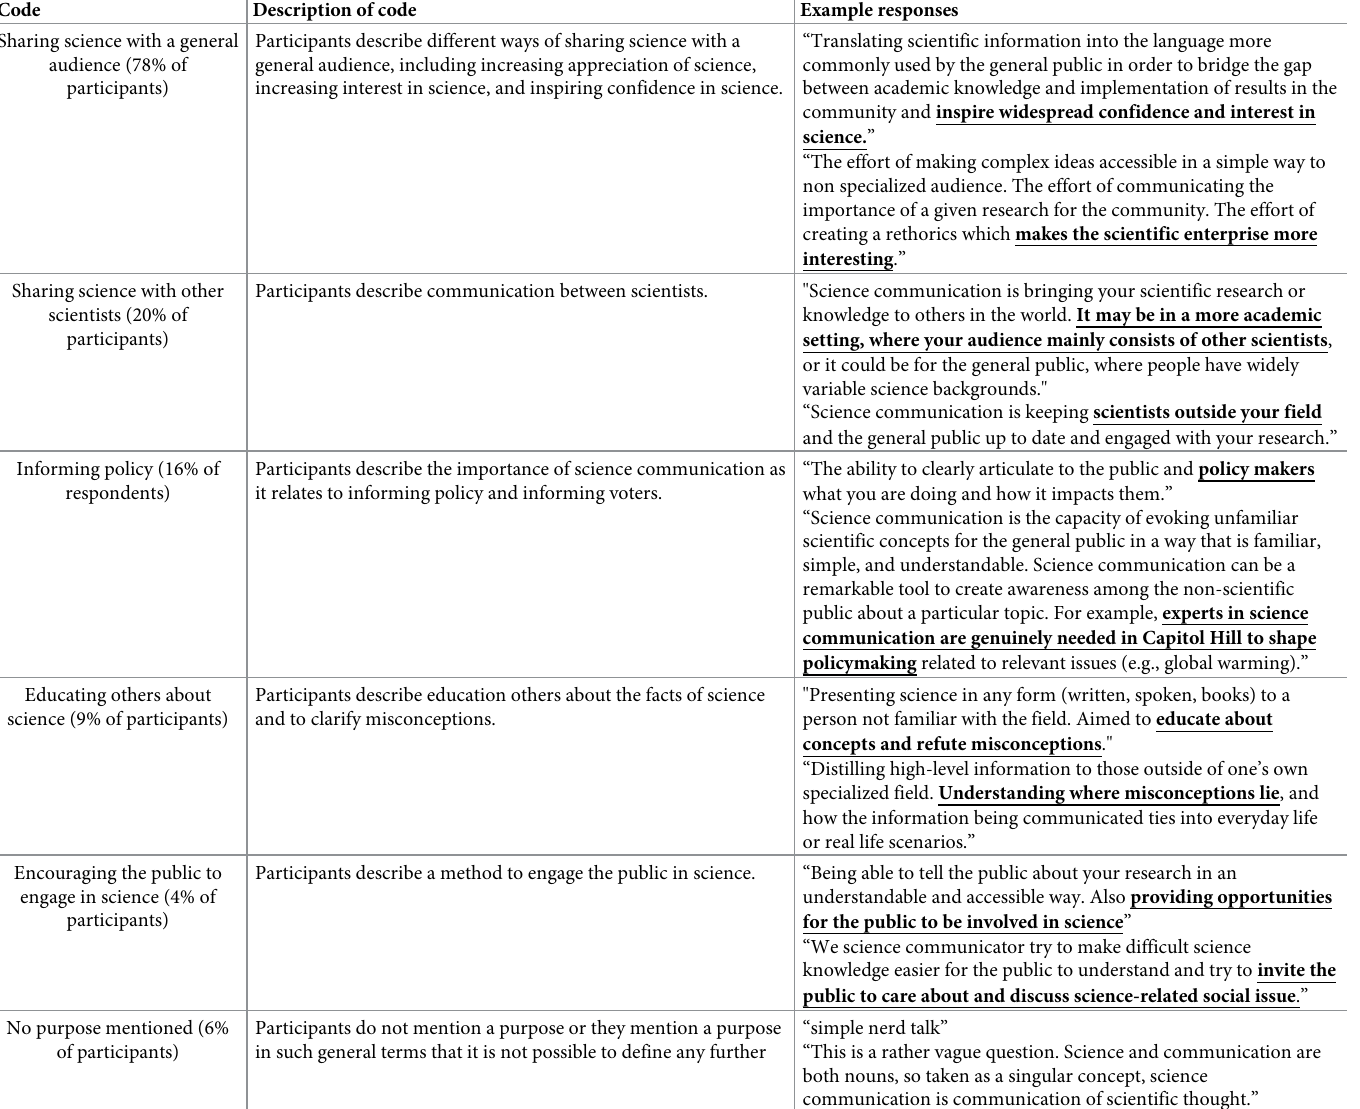
Table 4. The purpose of science communication as perceived by STEM graduate